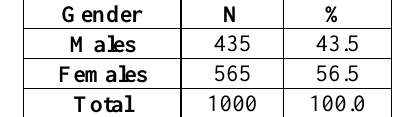
Table 2: The prevalence of the selected anomalies among the sample Anomalies (total